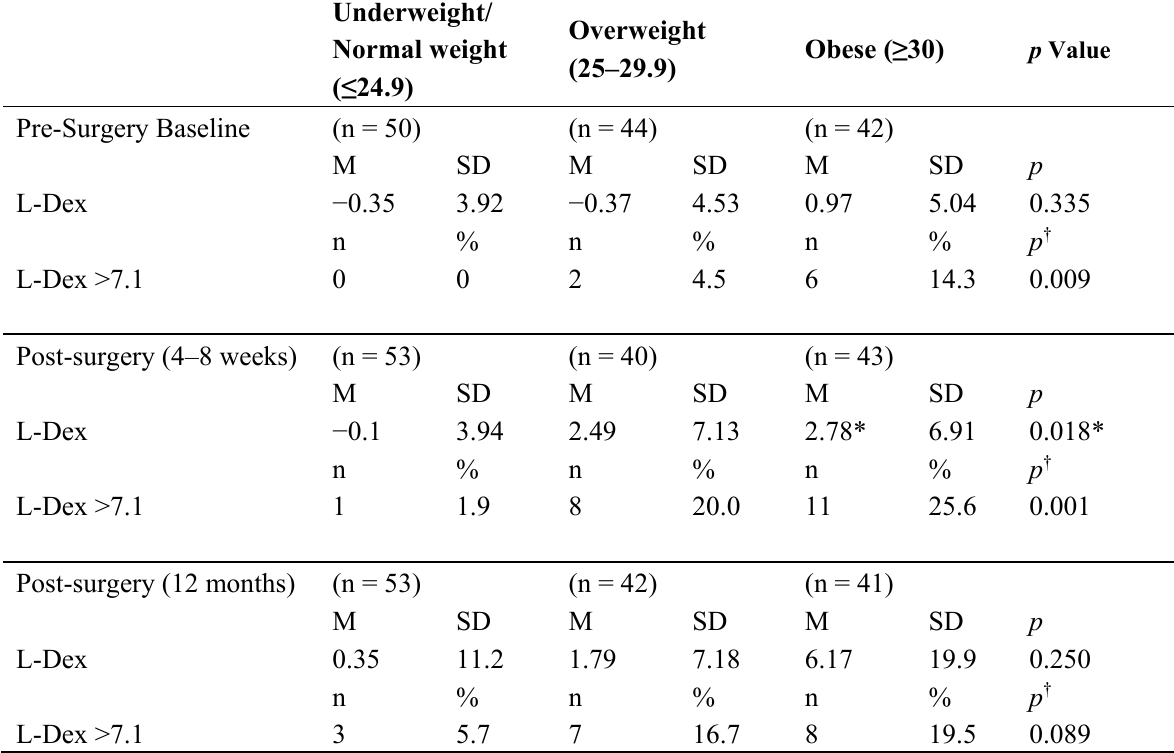
Table 4. L-Dex ratios by BMI category